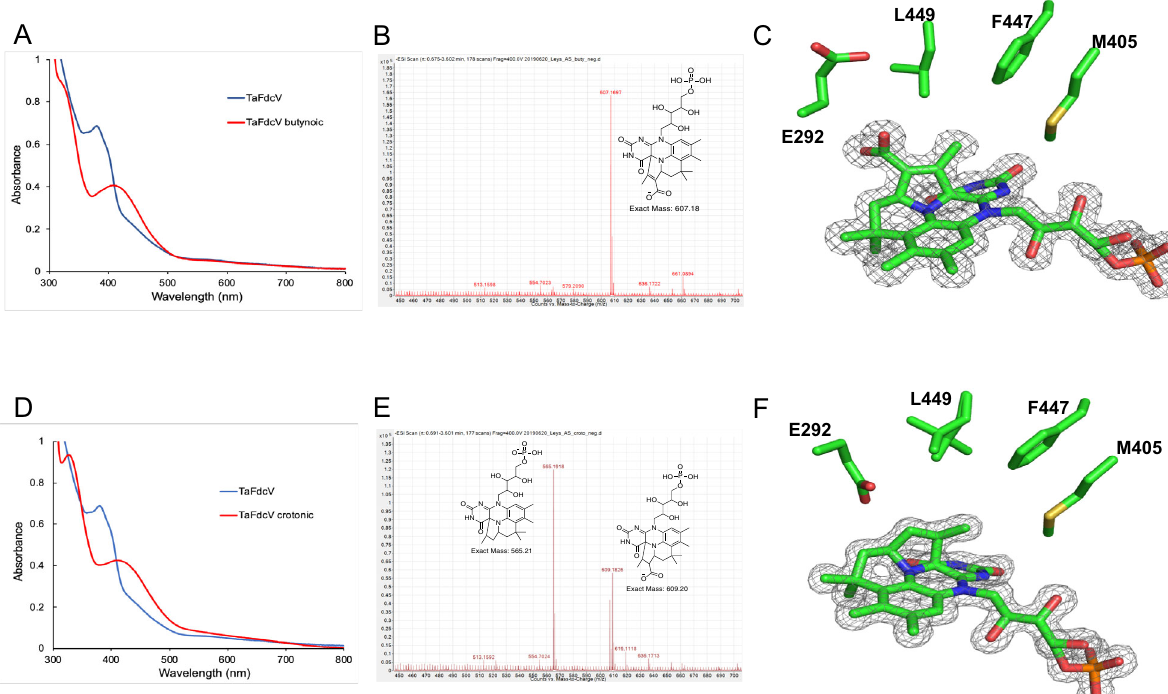
Fig. 3 Cycloadduct formation in TaFdcV with inhibitors butynoic and crotonic acid. A UV – Vis spectra of Ta FdcV before and after incubating with 2-butynoic acid. B ESI – MS spectra of Ta FdcV incubated with 2-butynoic acid and desalted, showing the formation of prFMN-butynoic adduct [M + H] + = 607.18. C Crystal structure of Ta FdcV with prFMN-butynoic adduct (7NF1 [10.2210/pdb7NF1/pdb]). D UV – Vis spectra of Ta FdcV as is and incubated with crotonic acid E ESI – MS spectra of Ta FdcV incubated with crotonic acid (and desalted) showing the formation of decarboxylated prFMN-crotonic adduct [M – H] − = 565.21 and traces of prFMN-crotonic with the carboxylate group [M – H] − = 609.20. F Crystal structure of Ta FdcV prFMN-crotonic adduct (7NF2 [10.2210/pdb7NF2/pdb]).